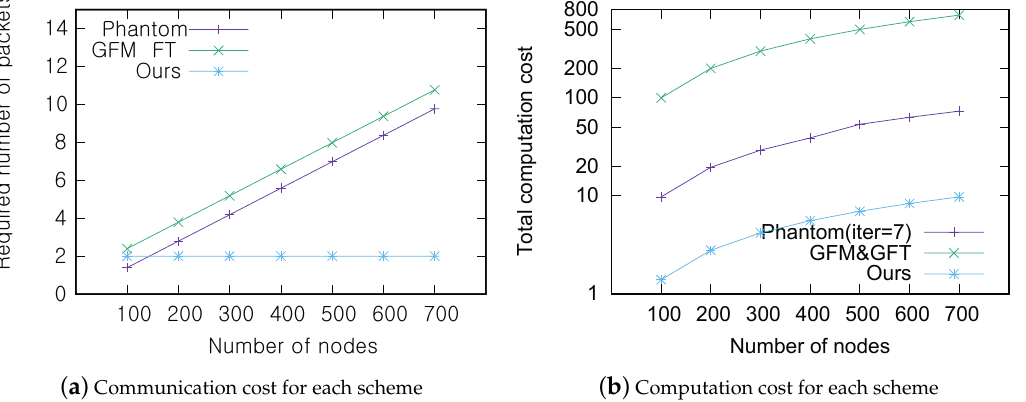
Figure 12. Cost for location verification of a single sensor: ( a ) communication cost for each scheme and ( b ) computation cost for each